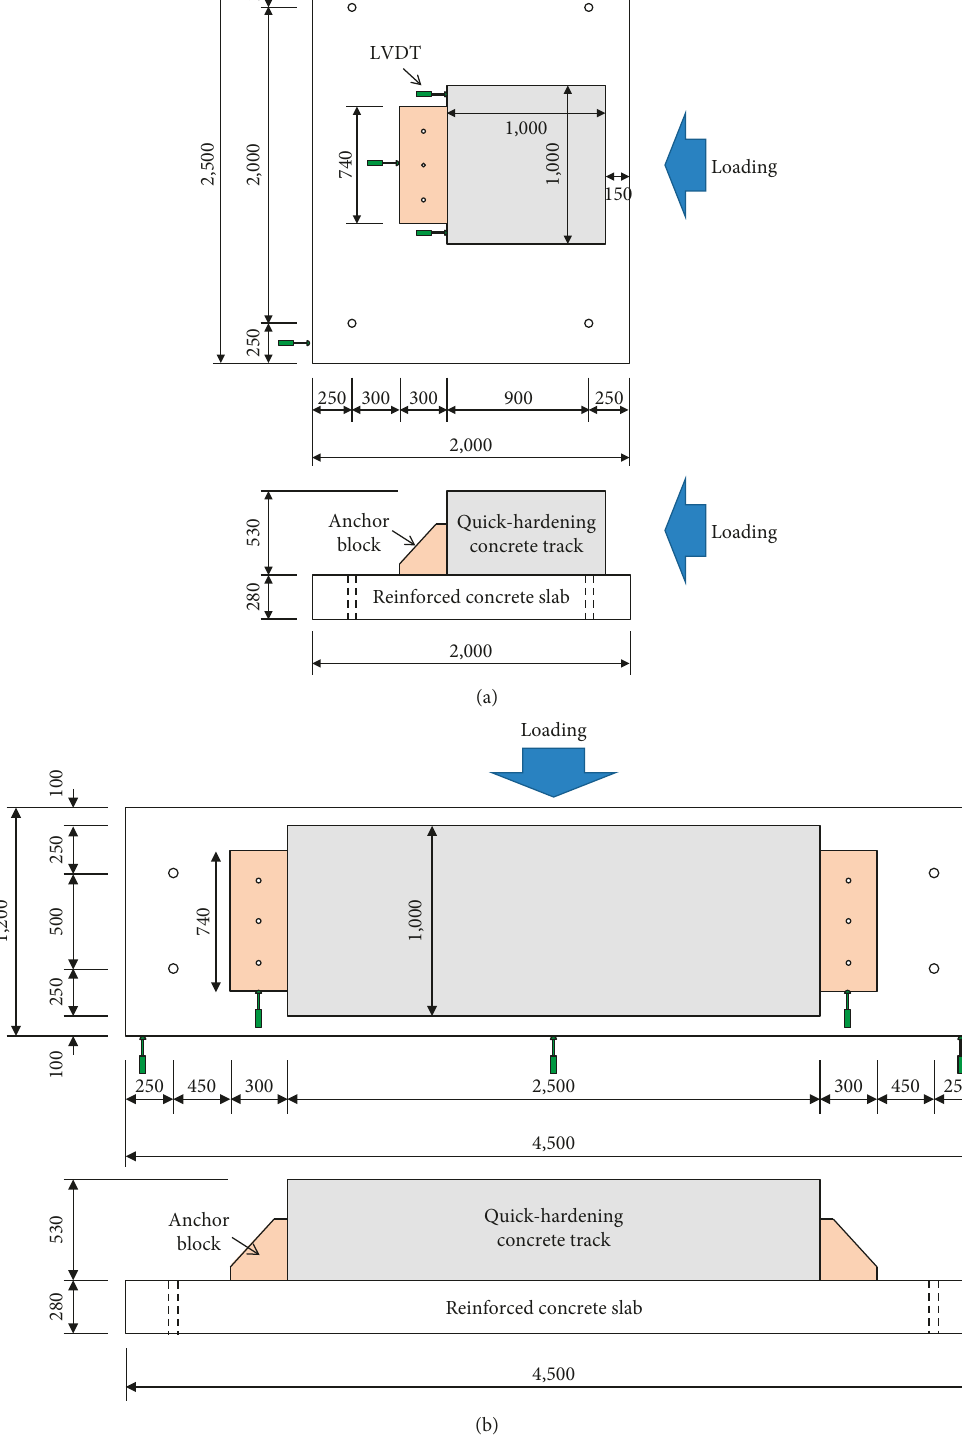
Figure 7: Details of the specimens and instrumentations: (a) Specimen AT and (b) Specimen